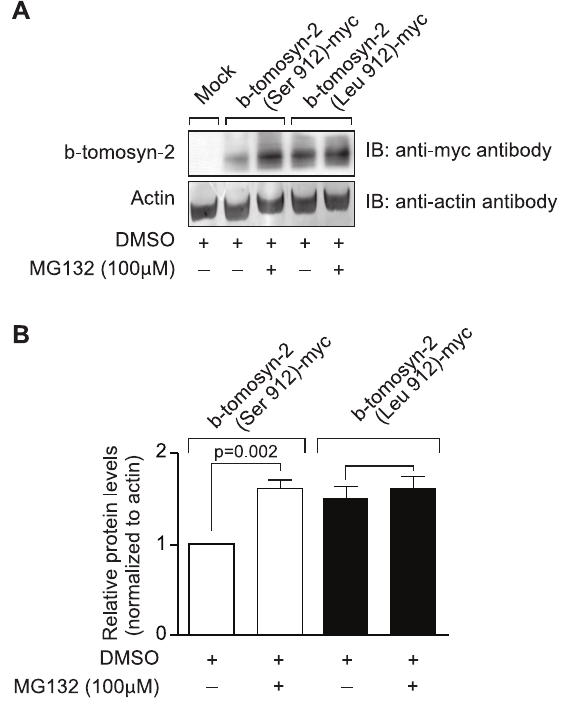
Figure 9. Effect of proteasomal inhibitor on B6 and BTBR allele of b-tomosyn-2. A) The mammalian expression plasmid containing the mock, b-tomosyn-2 (Serine912)-myc or b-tomosyn-2 (Leucine-912)- myc were transfected in HEK293Tcells. After 16 h incubation in DMEM supplemental media, cells expressing b-tomosyn-2-myc were treated with MG132 (100 m M) or DMSO for 6 h. Equal amounts of protein were subjected to western blot analysis and the level of b-tomosyn-2-myc protein was determined using anti-myc antibody. The actin was used as a loading control. B) Shows the quantitation of the signals for three experiments. Values are means 6 S.E. of N=3. * p # 0.05 for the expression of b-tomosyn-2-myc in the samples treated with MG132 vs.